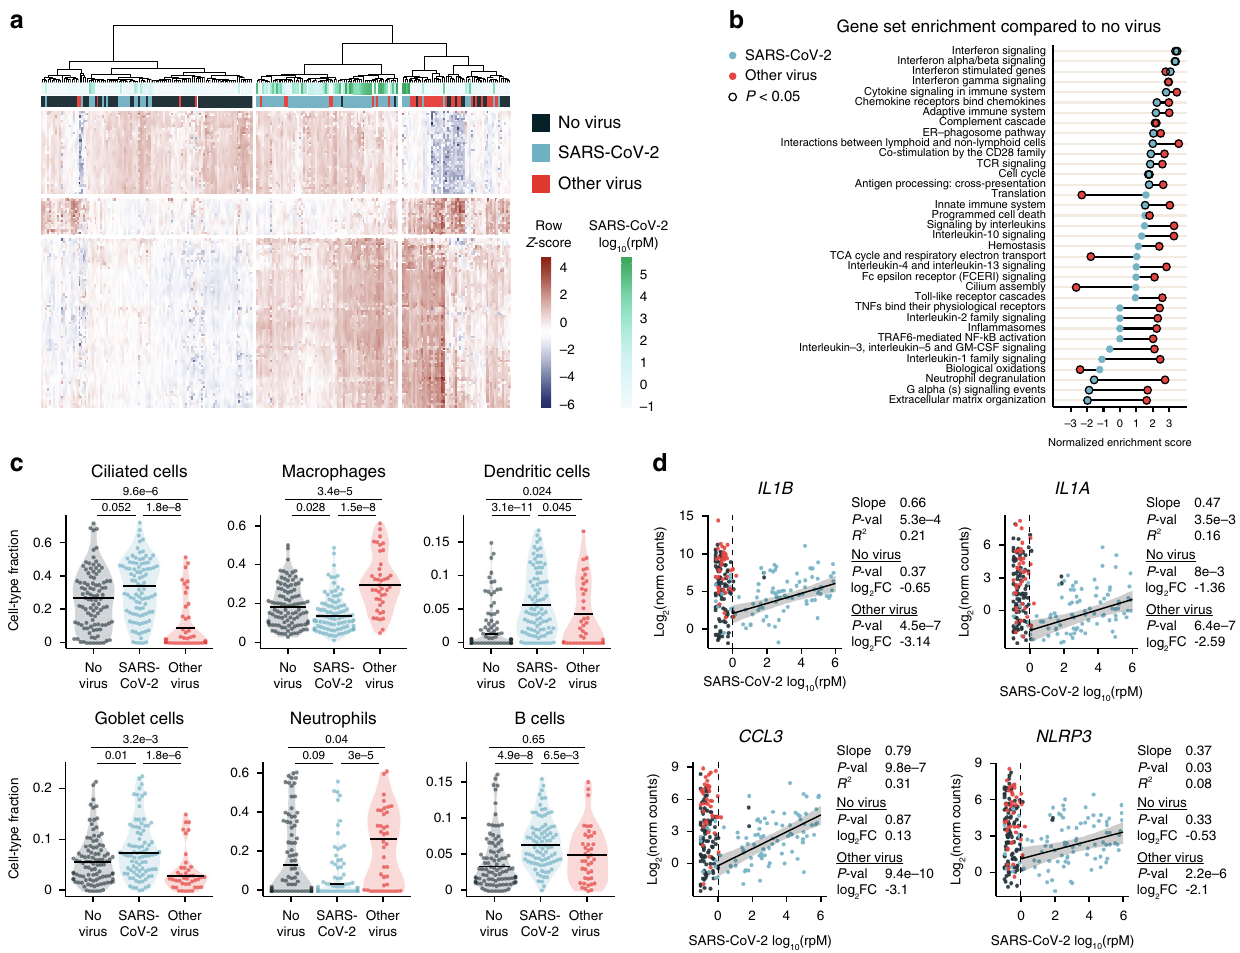
Fig. 1 Host Transcriptional Signatures of SARS-CoV-2 Infection as Compared to Other Respiratory Viruses. a Hierarchical clustering of 121 genes comprising the union of the top 50 differentially expressed (DE) genes by signi fi cance in each of the pairwise comparisons between patients with COVID- 19 (SARS-CoV-2; n = 93), other viral ARIs ( n = 41) and non-viral ARIs ( n = 100). Gene expression values were clustered after variance-stabilizing transformation and row normalization. Group labels and viral load of SARS-CoV-2 are shown in the annotation bars. rpM, reads-per-million. b Normalized enrichment scores of selected REACTOME pathways that achieved statistical signi fi cance in at least one of the gene set enrichment analyses, using either DE genes between SARS-CoV-2 and non-viral ARIs or between other viral ARIs and non-viral ARIs. If a pathway could not be tested in one of the comparisons since it had <10 members in the input gene set, the enrichment score was set to 0. Pathway p -values were calculated using an adaptive, multilevel splitting Monte Carlo approach and Benjamini – Hochberg adjusted. c In silico estimation of cell-type proportions in the bulk RNA sequencing using single-cell signatures. Black lines denote the median. The y-axis in each panel was trimmed at the maximum value among the three patient groups of 1.5*IQR above the third quartile, where IQR is the inter-quartile range. Pairwise comparisons between patient groups were performed with a two-sided Mann – Whitney – Wilcoxon test followed by Bonferroni ’ s correction. Sample sizes as in ( a ). d Scatter plots of normalized gene counts (log 2 scale, y -axis) as a function of SARS-CoV-2 viral load (log 10 (rpM), x -axis). Shown are in fl ammasome-related genes selected from among the genes most depressed in expression in SARS-CoV-2 compared to other viral ARIs. Robust regression was performed on SARS-CoV-2 positive patients with log 10 (rpM) ≥ 0 ( n = 82) to characterize the relationship to viral load. Shaded bands represent 95% con fi dence intervals. Statistical results listed for each gene refer to, from top to bottom: the regression analysis ( p -values for difference of the slope from 0 derived from a t -statistic and Benjamini – Hochberg adjusted; R 2 is the adjusted robust coef fi cient of determination), the DE analysis between SARS-CoV-2 and non-viral ARIs ( p -values derived from a moderated t -statistic